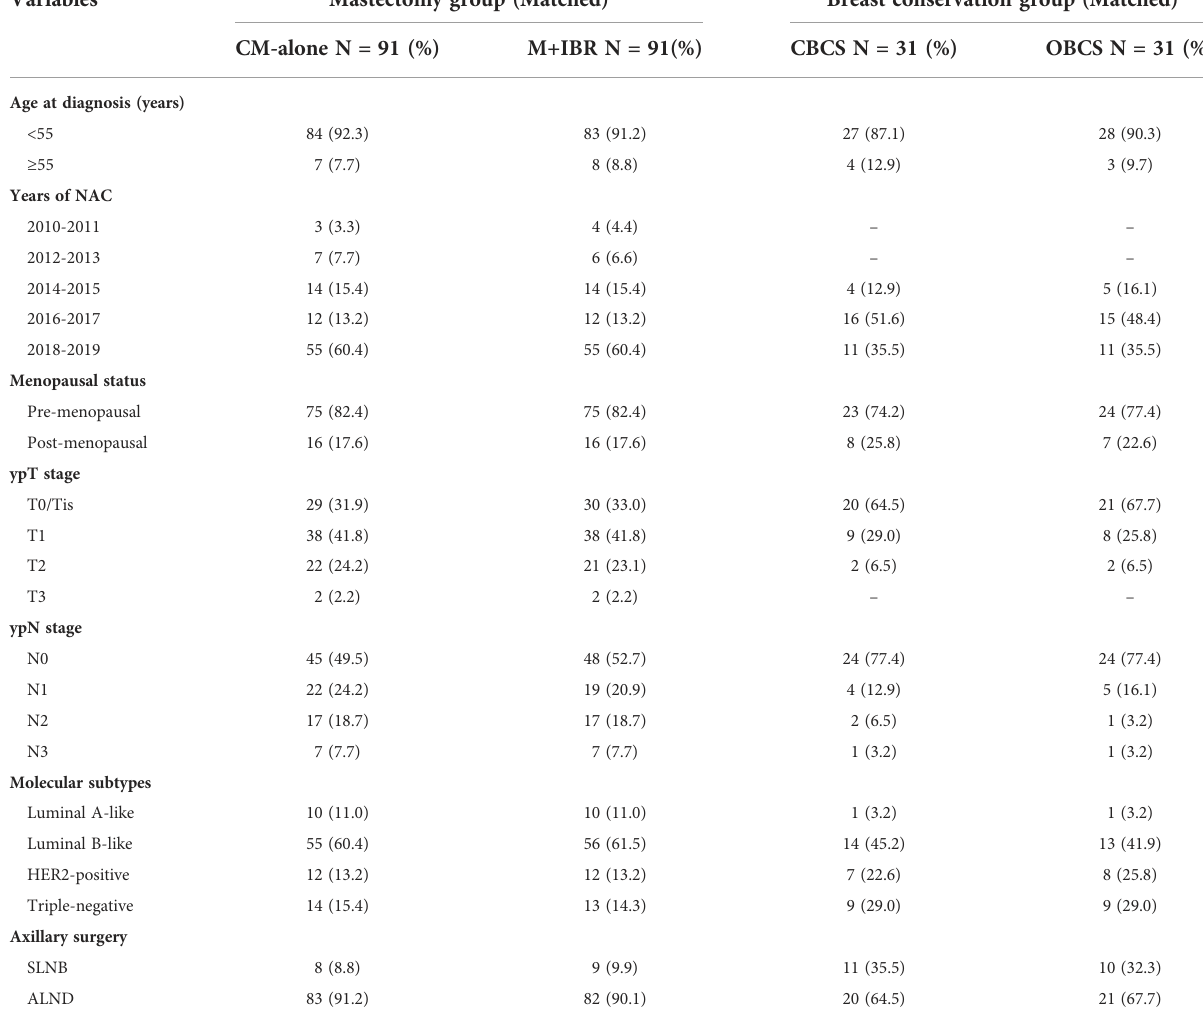
TABLE 4 Matched patients receiving different surgical intervention in mastectomy group and breast conservation group after propensity score matching. Variables Mastectomy group (Matched) Breast conservation group